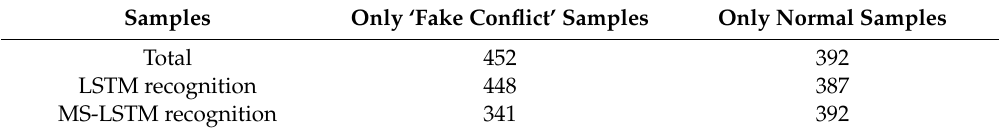
Table 10. Validation performance when training in fake conflict samples or normal samples.